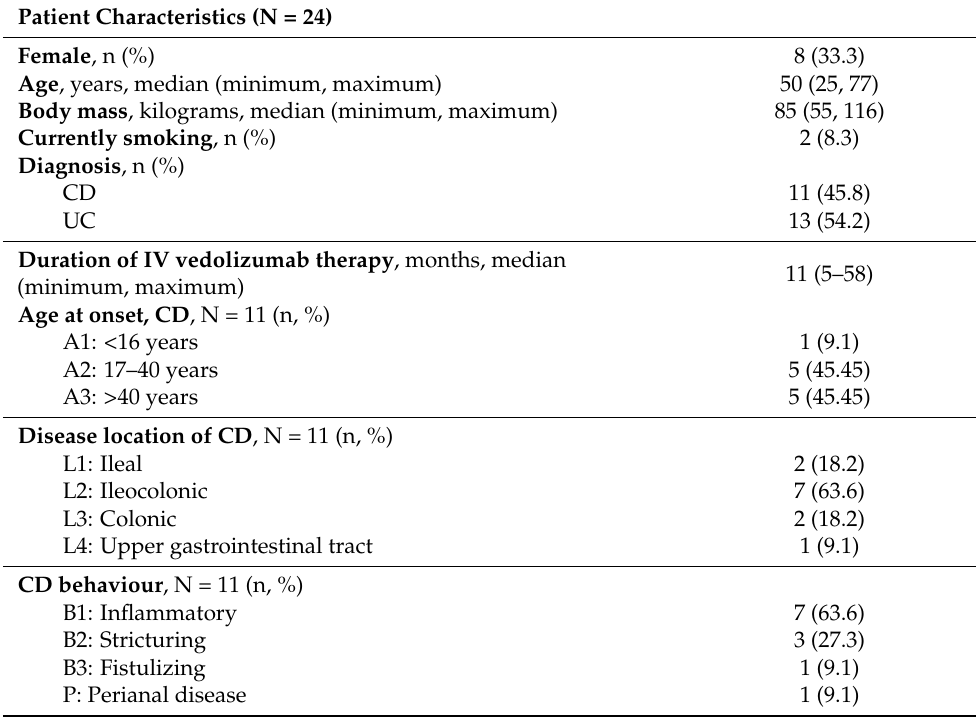
Figure 1. Algorithm of patients’ enrolment in the study. Table 1. Baseline patients’